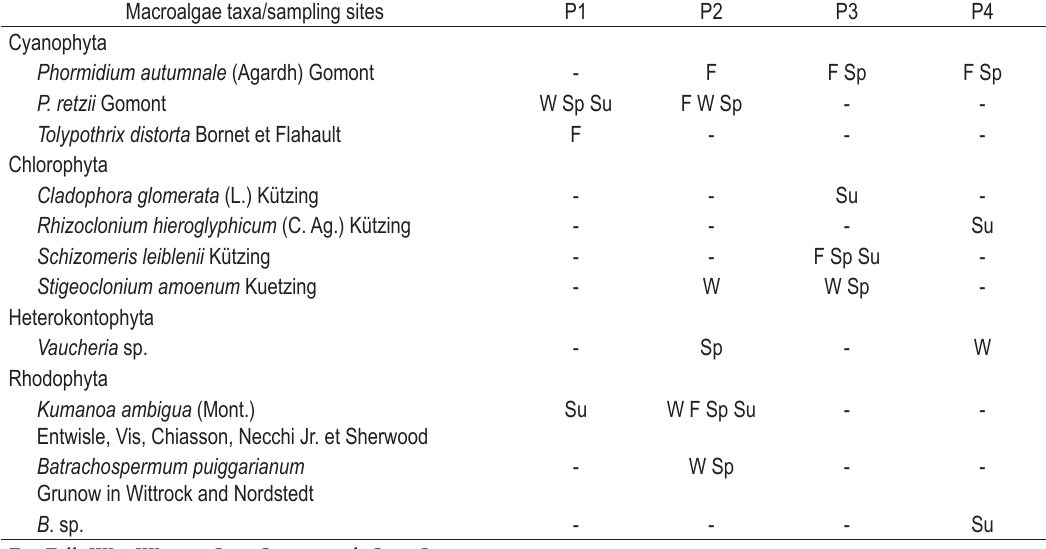
Table 3. Occurrence of macroalgal species by sampling site and season in the Cascavel Stream, Guarapuava, Paraná State.